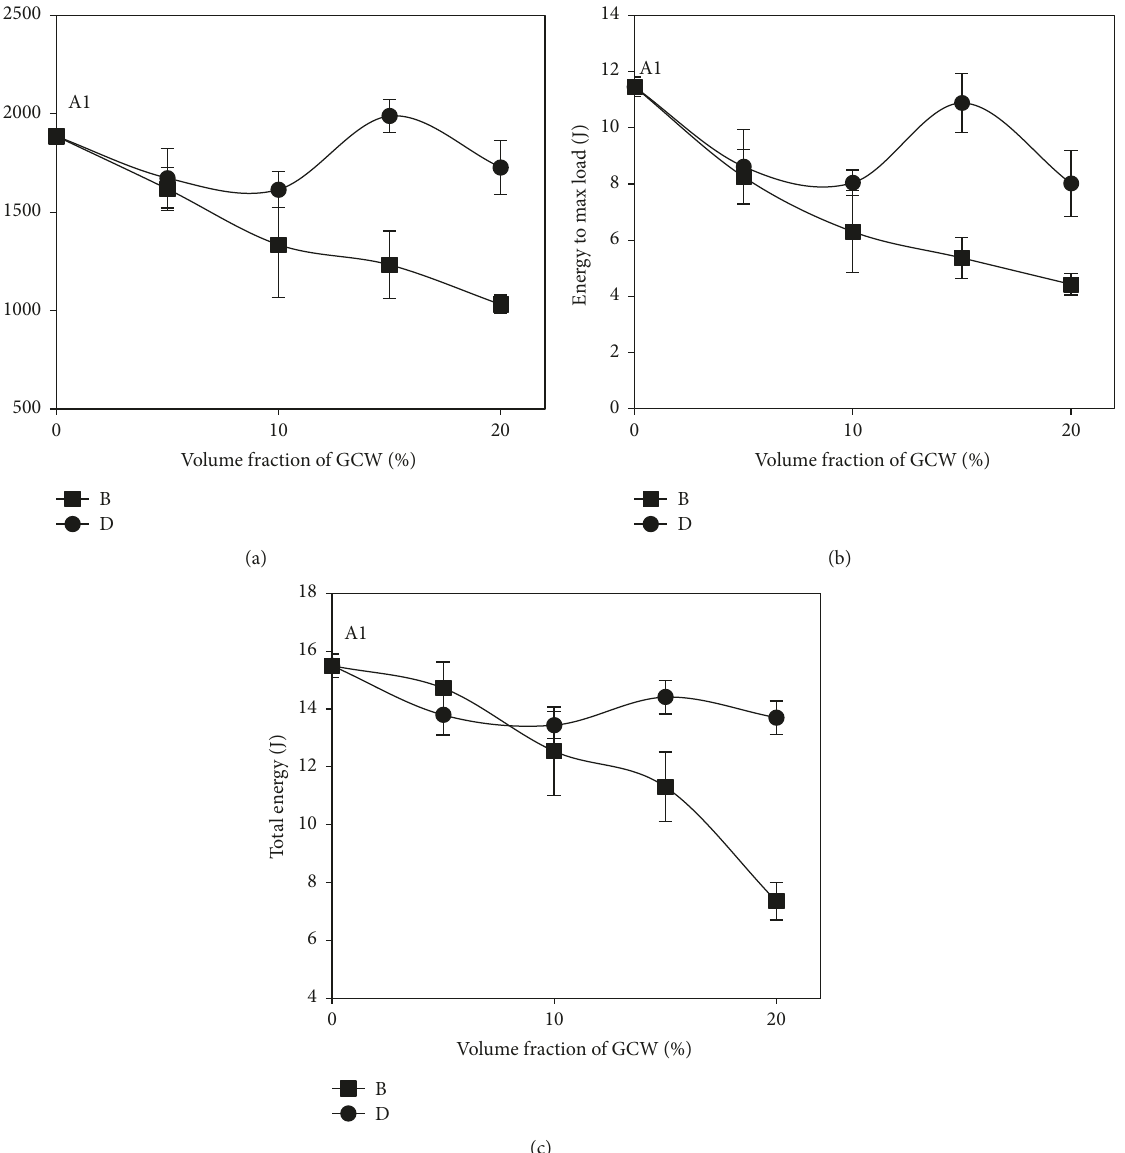
Figure 9: Effect of volume fraction of GCW on (a) load; (b) energy to maximum load; (c) total energy of composites types B and